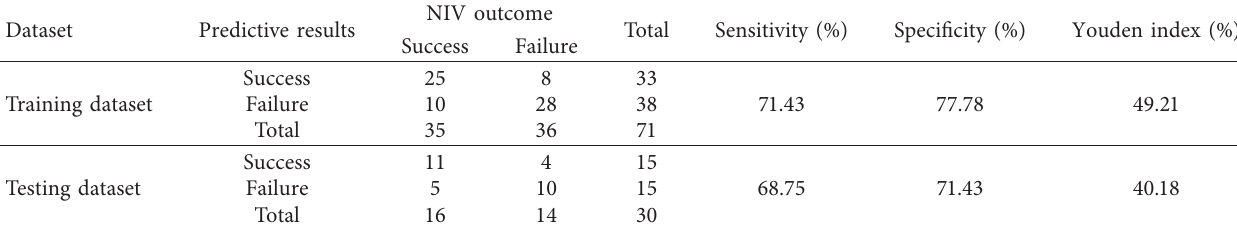
Table 3: Evaluation of predictive model for NIV